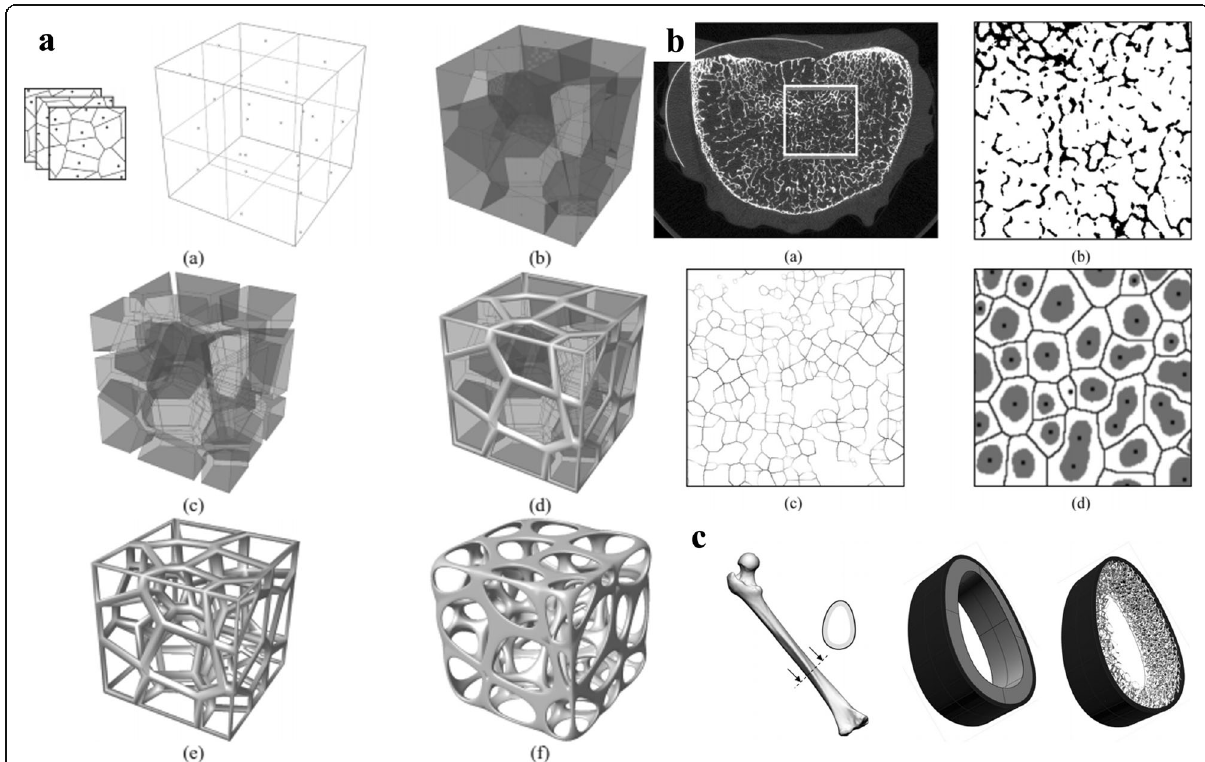
Fig. 16 Design method of scaffold: a 3D Voronoi to generate porous structures. b Voronoi tessellation from CT images. c Generate infill scaffolds